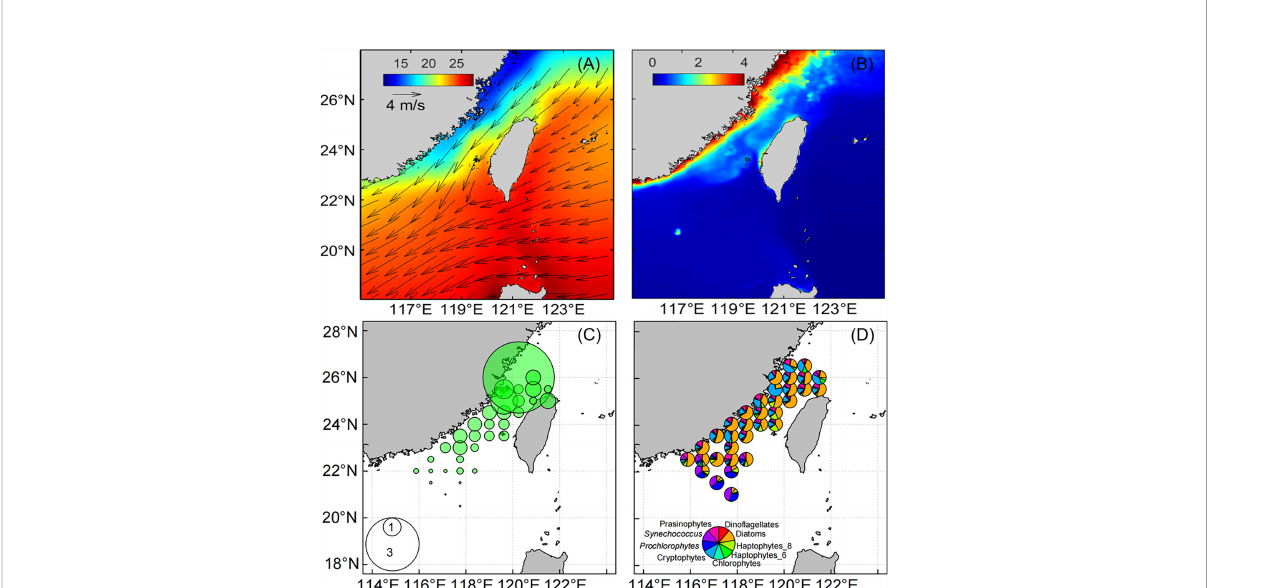
FIGURE 1 The climatological mean sea surface temperature (shading, in °C, A ), wind velocity at 10 m above the sea surface (vectors, in m/s, A ), chlorophyll a concentrations ( m g L − 1 , B ) based on the satellite data between February and April during 1998 – 2018, total chlorophyll a concentrations ( m g L − 1 , C ) and phytoplankton community structure (D) based on the HPLC analysis between February and April during 2012 – 2018. All data are averaged over 0.5°×0.5° grid